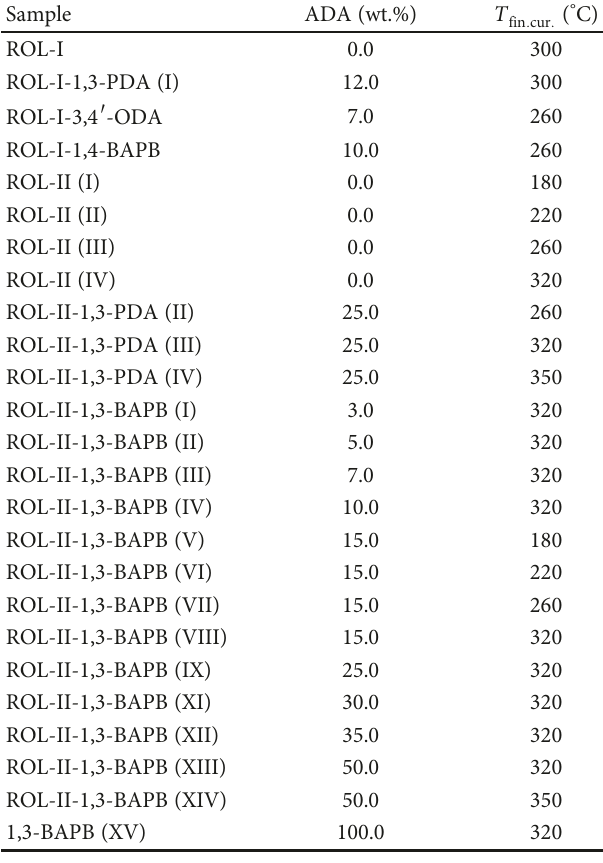
Table 2: Contents of ADA in blend samples and their fi nal curing temperatures T fin cur